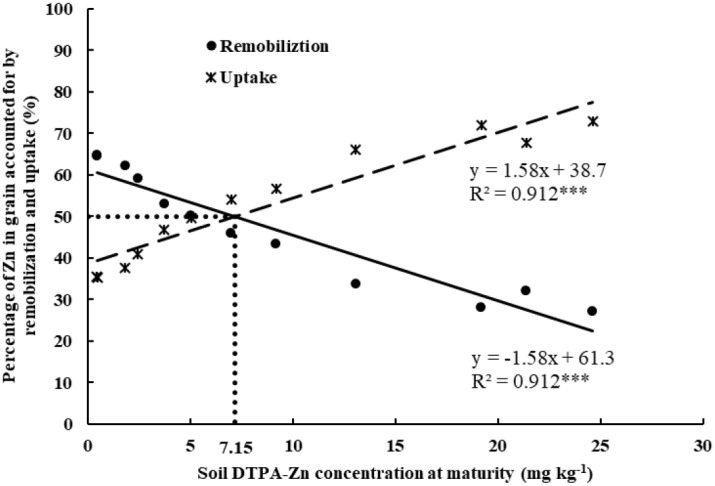
Relationship between soil DTPA-Zn concentration at maturity and share of wheat grain Zn provided by remobilization of pre-anthesis (%) and post-anthesis shoot uptake (%) in 2013–2014 and 2014–2015 cropping seasons. The linear regressions are significant difference at P < 0.001. The dotted vertical line indicates the soil DTPA-Zn concentration at which Zn remobilization and Zn uptake contribute equally to grain Zn content.